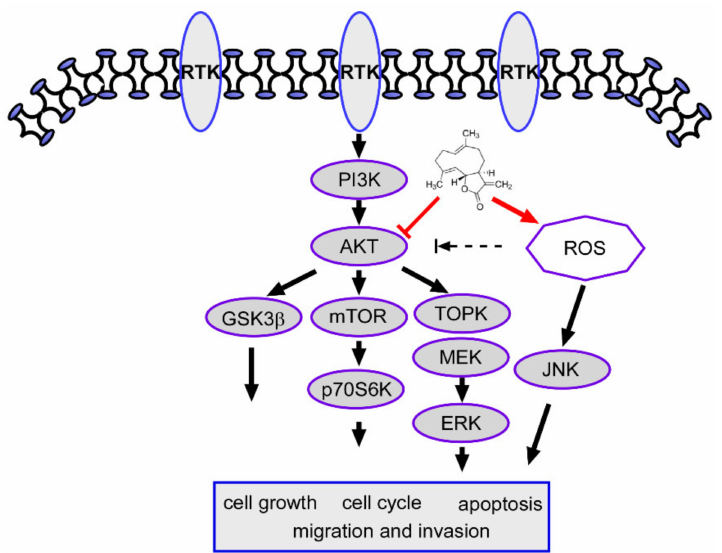
Figure 10. Costunolide inhibits oral cancer cell proliferation and induces apoptosis through the ROS and AKT signaling